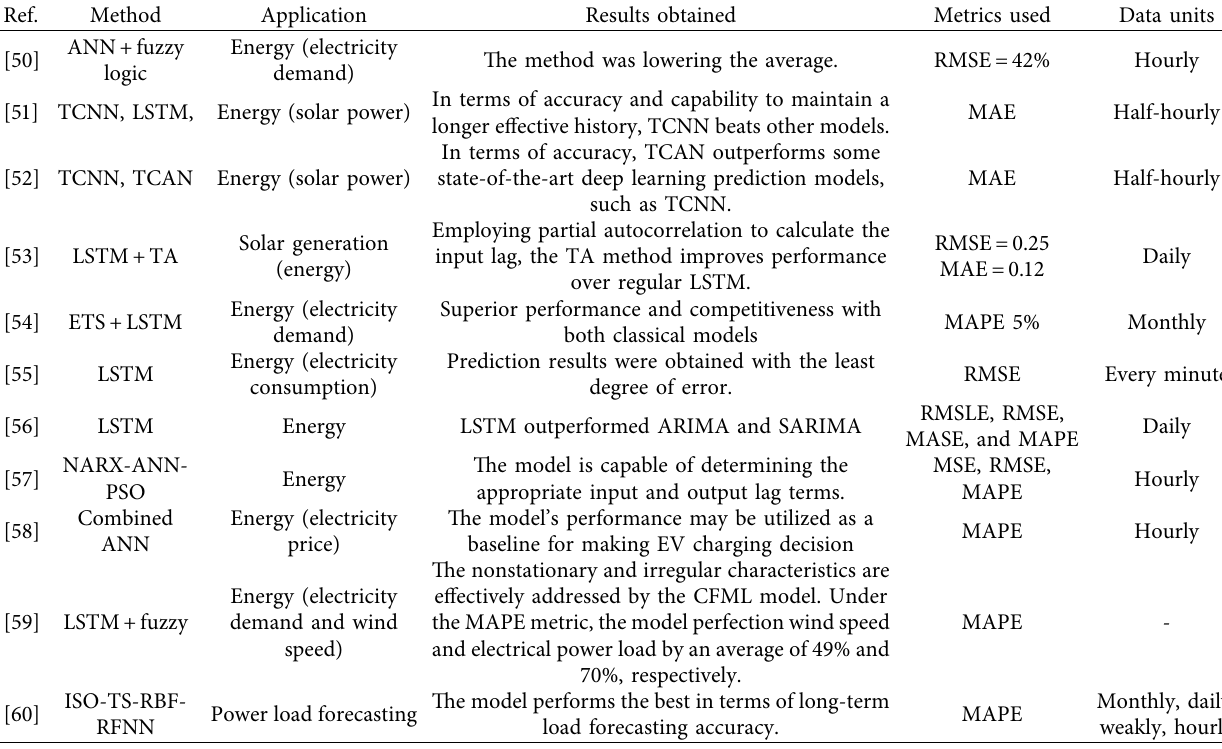
Table 2: A summary of published articles that used deep sequential models in energy predictions.